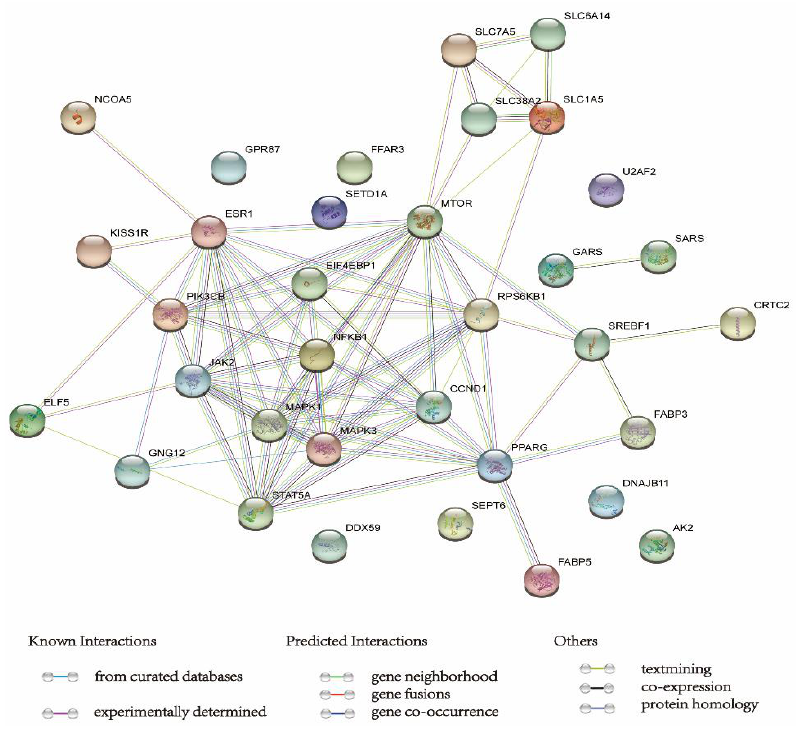
Figure 2. Network of lactation-related proteins under nutritional supplementation.